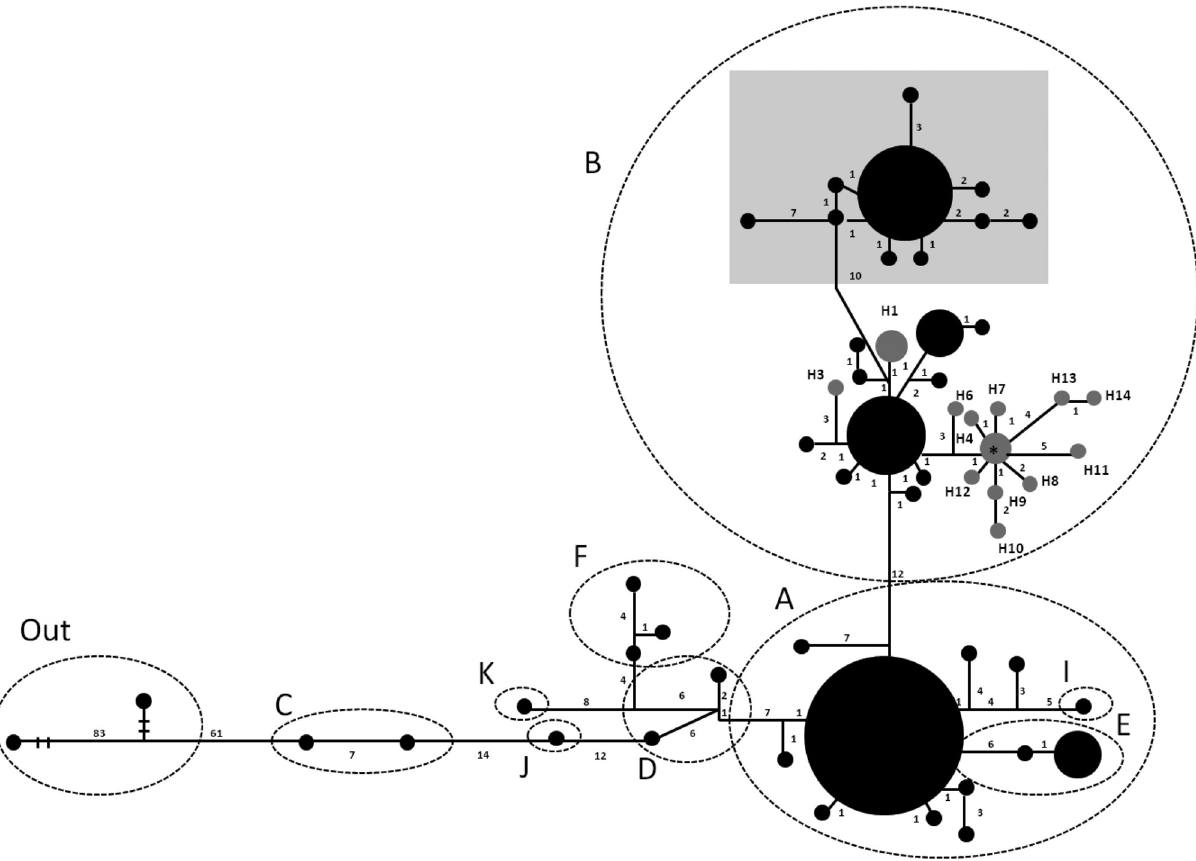
Figure S1 - Median-joining network of Wolbachia 16S rDNA sequences from Balloniscus species. A, B, C, D, E, F, I and J represent Wolbachia supergroups traditionally recognized and Out identifies the sequences used as outgroup (see Figure 2); The Oni clade is represented inside a grey square; numbers associated with some branches represent the number of mutational steps; H1, H3, H4, H5, H6, H7, H8, H9, H10, H11, 12, H13 and H14 (*H2) represent the different sequences found in Balloniscus , and are represented in grey. Wolbachia 16S sequences obtained from other species and used for